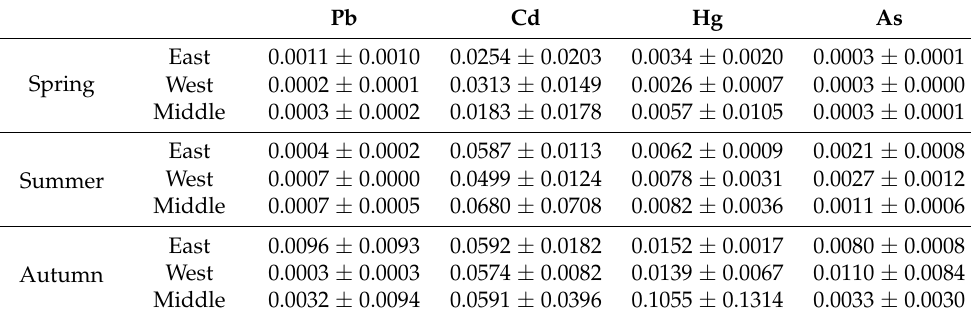
Table 4. BCF of metals in different seasons and regions.